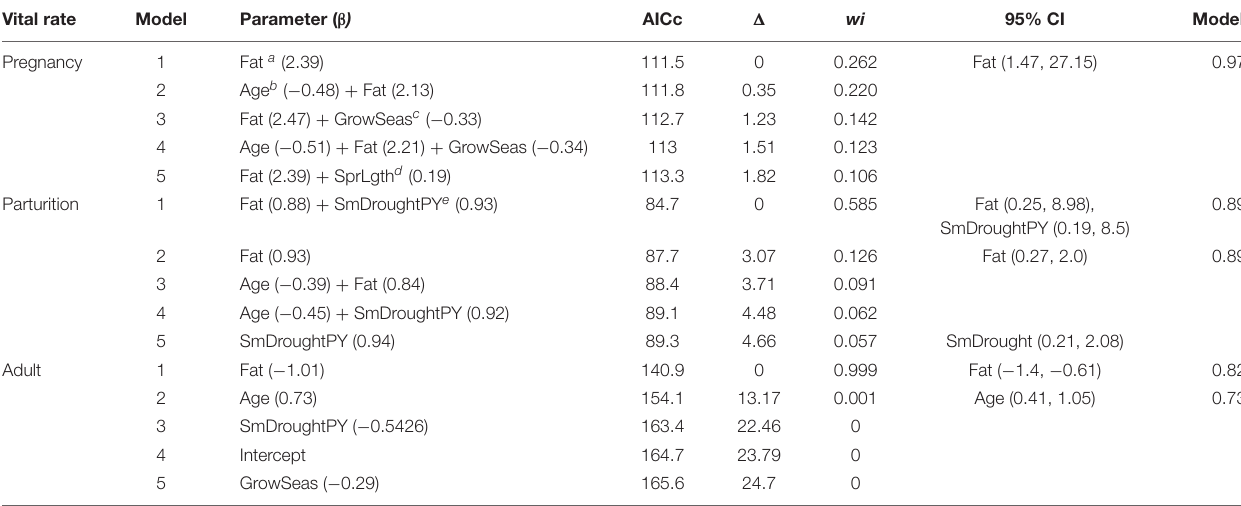
TABLE 3 | Top models derived from AIC c model selection with coefficient estimates and 95% confidence intervals (of all terms in model) that did not overlap zero for Sublette moose ( n = 70 individuals) from 2012 to 2014. Vital rate Model Parameter ( β ) AICc (cid:49) wi 95%